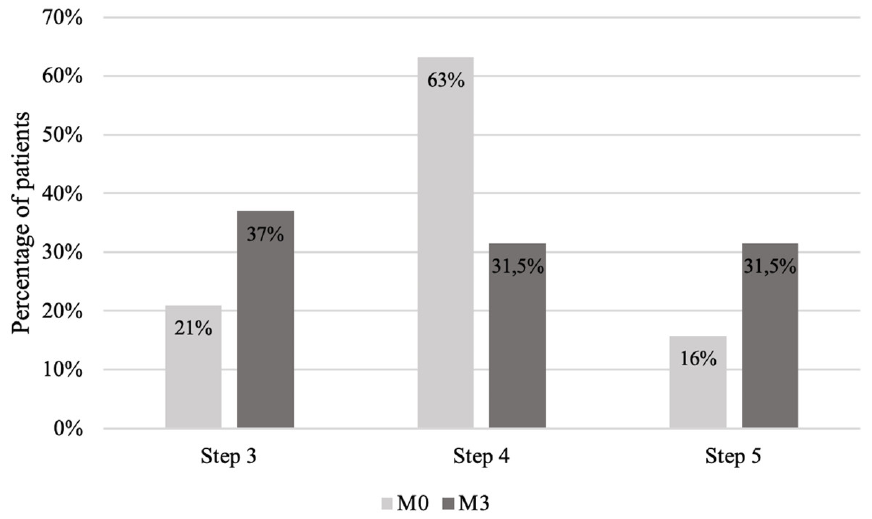
Figure 7. Treatment steps according to GINA (Global Initiative for Asthma) at the beginning (M0) and at the end (M3) of the study.